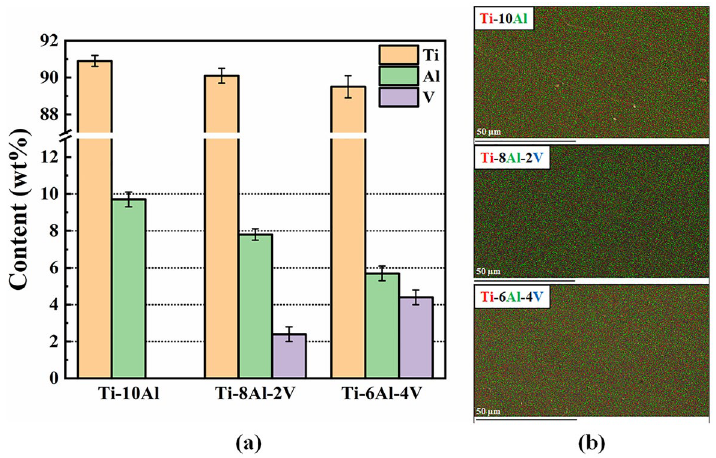
Figure 1. EDS chemical analysis: ( a ) Semi-quantitative results and ( b ) Elemental mapping.